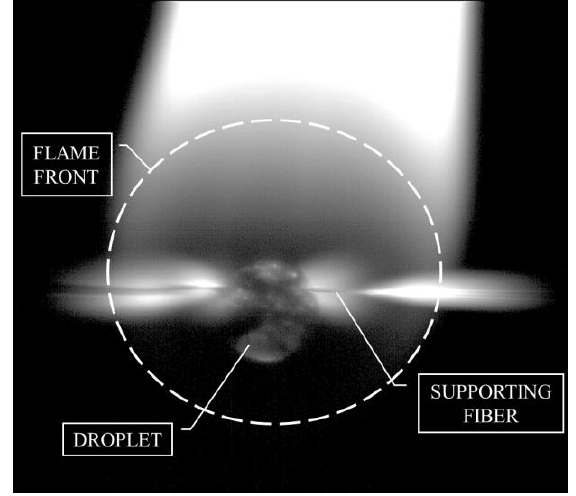
Figure 14. Flame structure of a Pennsylvania crude oil droplet.